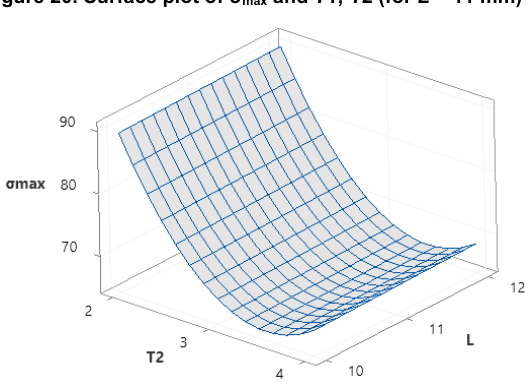
Figure 18. Surface plot of max ∈ and T 2; L (for T 1 = 1 mm)